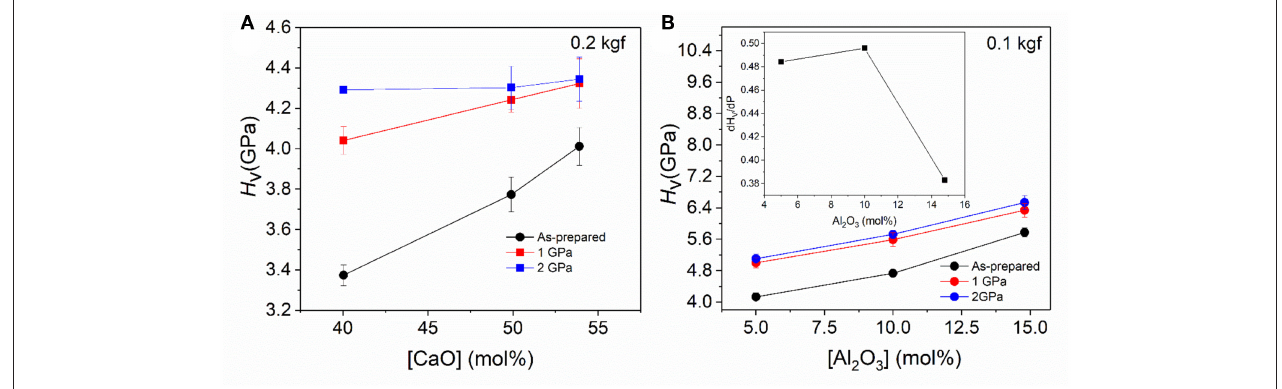
FIGURE 8 | Composition and pressure dependence of Vickers Hardness ( H V ) of (A) CaO-P 2 O 5 glasses and (B) CaO-Al 2 O 3 -P 2 O 5 glasses. Inset in (B) shows d H V /d P at 2 GPa, featuring similar trend as the plastic compressibility of the glasses at 2 GPa.